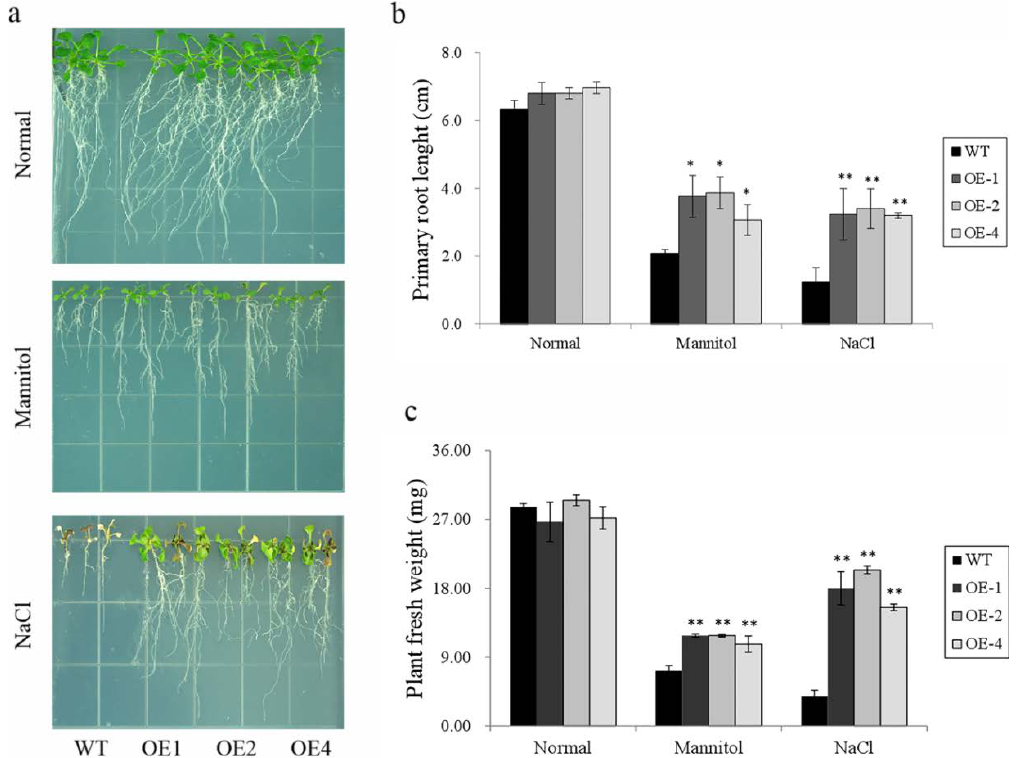
Figure 7. Responses of the transgenic Arabidopsis and WT seedlings cultured on MS medium with no stress, 300 mM mannitol, or 125 mM NaCl for 15 days. ( a ) Phenotype of WT and transgenic lines grown under di ff erent stresses; ( b ) primary root length of the WT and transgenic lines shown in ( a ); and ( c ) fresh weight of the WT and transgenic lines shown in ( a ). Data are presented as means ± SE (n = 3); * indicates a significant di ff erence at p < 0.05, and ** means a significant di ff erence at p <